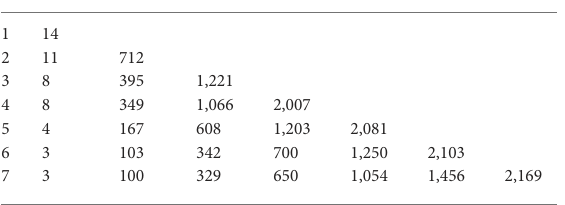
TABLE 2 Center frequencies corresponding to different K values in summer.